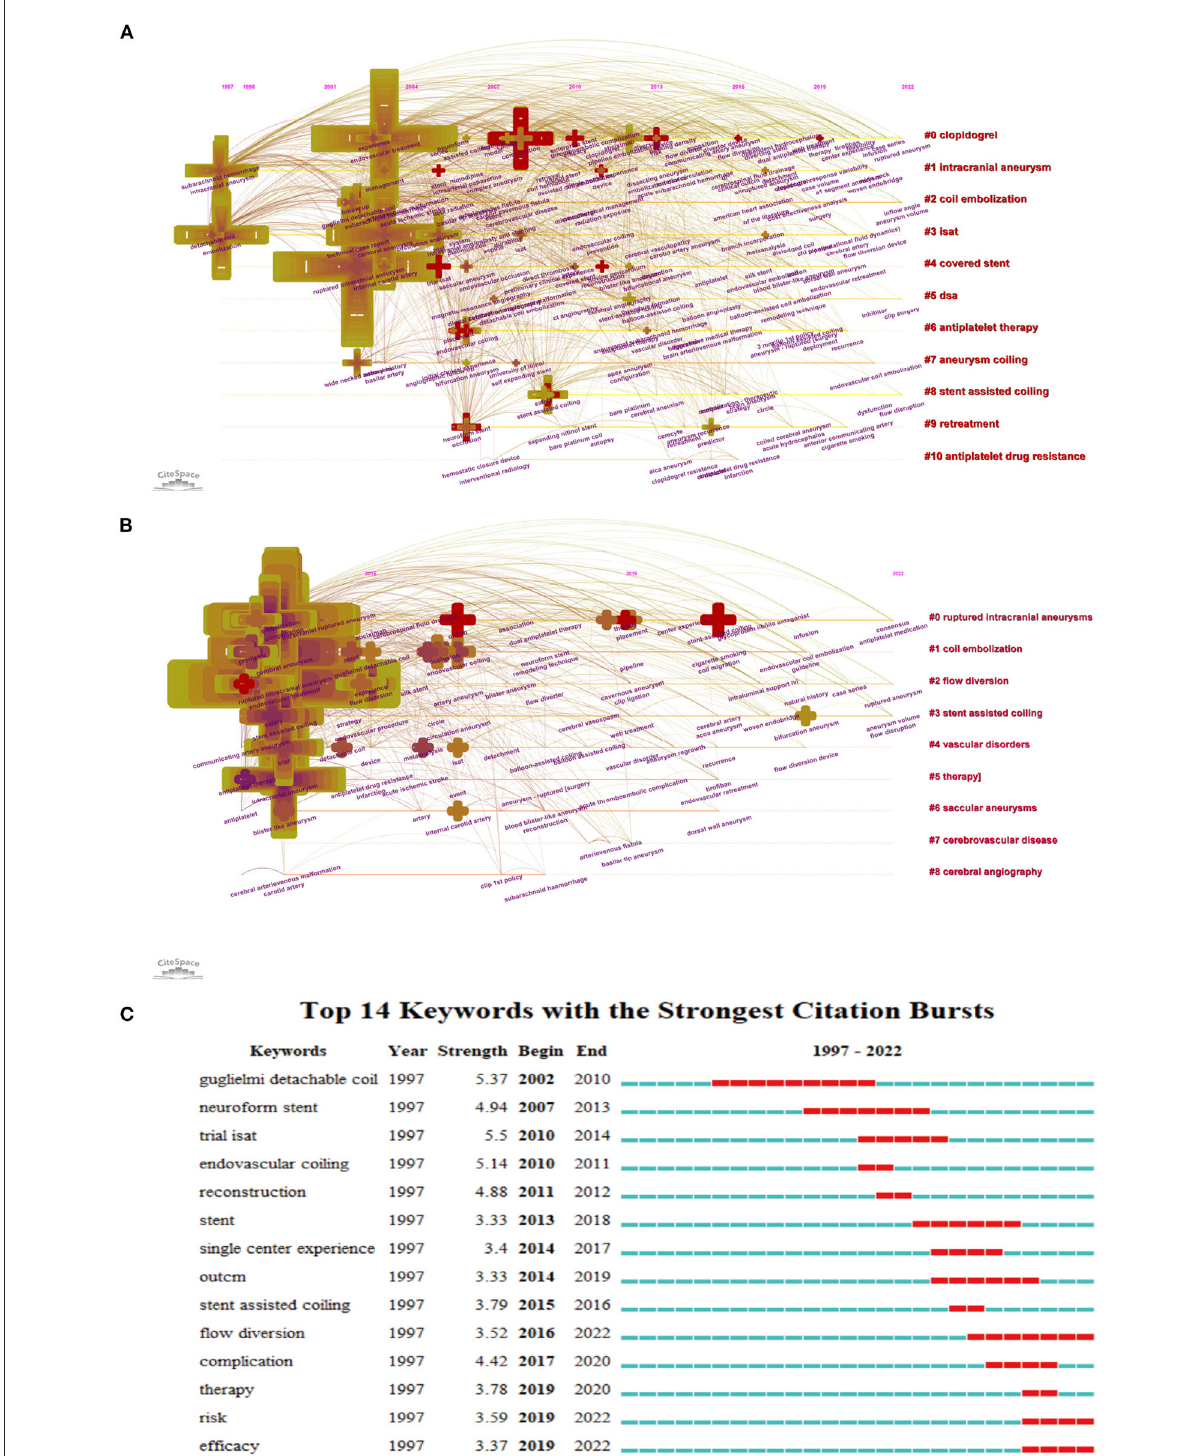
FIGURE3 Timeline visualization of co-occurring author keyword networks [ (A) 1980–2021 and (B) 2015–2022]. The size of a cross is proportional to the burstness of keywords co-occurrence. The co-occurring keyword network is weighted on total link strength across different keyword nodes and scored on the mean publication years. The clusters are labeled in red at the right of the timeline maps. (C) Top14 keywords with the strongest citation